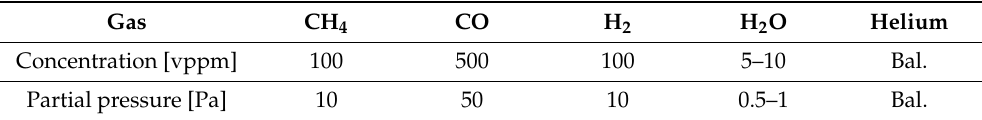
Table 2. Gaseous composition of the helium